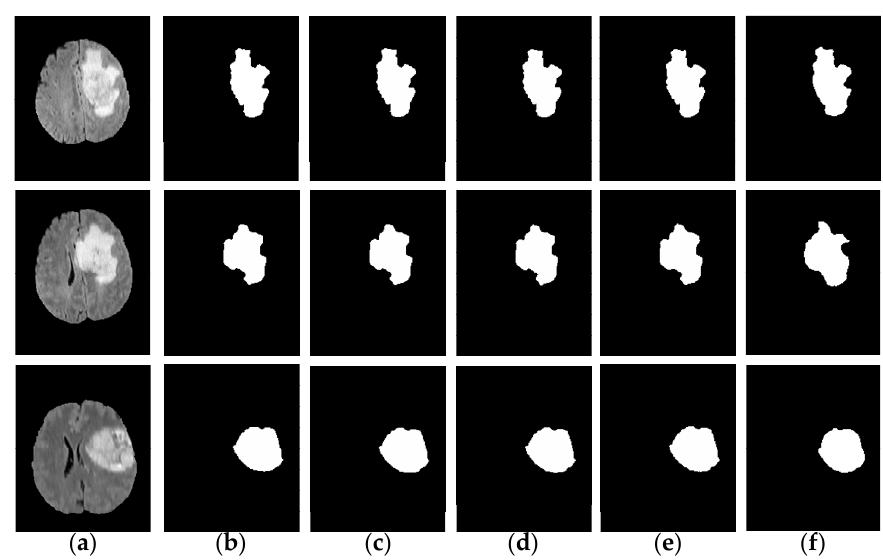
Figure 4. Tumors extracted under different noise intensities. ( a ) Original image. ( b – e ) Results (the noise intensities are 0, 0.005, 0.01 and 0.02, respectively). ( f ) Ground truth.